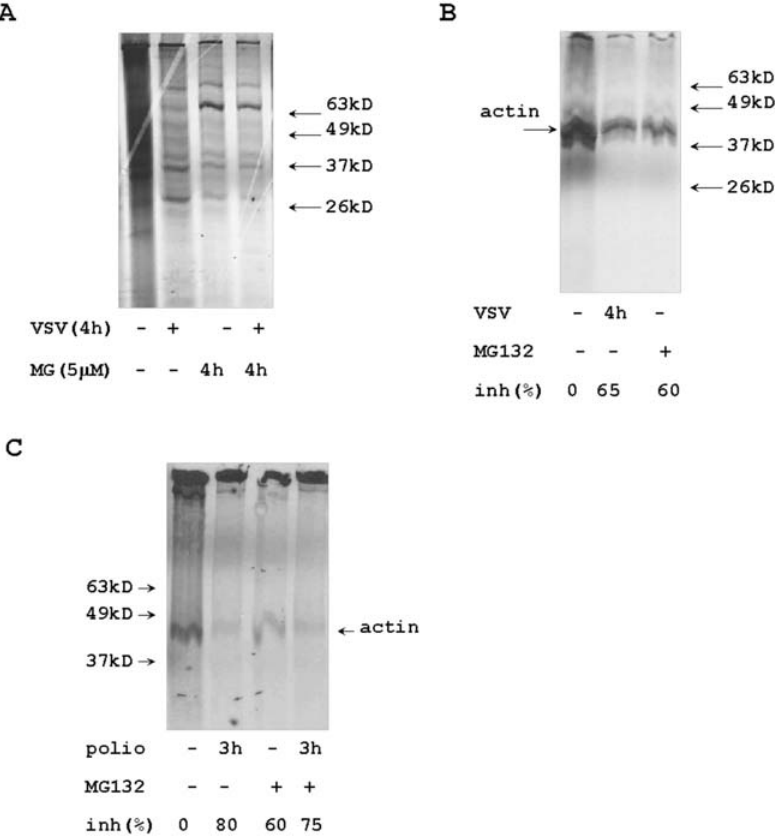
Figure 8. The effect of MG132 and virus infection on cellular protein synthesis. (A) Protein extracts were purified from control HeLa cells, cells infected with VSV for 4 h, cells treated with 5 m M of MG132 for 4 h, and cells infected with VSV and treated with MG132 for 4 h. All cells were incubated with S 35 methionine/cysteine for last 30 min before the protein extracts purification. Cytoplasmic protein extracts were analyzed by electrophoresis and autoradiography. (B) Cytoplasmic protein extracts from control, VSV infected, and MG treated cells were precipitated with anti- actin Abs, and the complexes were purified on protein A agarose. S 35 labeled actin was analyzed by electrophoresis and autoradiography. (C) Cytoplasmic S 35 -labeled protein extracts from MG-treated and poliovirus-infected cells were precipitated with anti-actin Abs and analyzed as described in panel B. All protein bands’ intensity was detected by ImageJ software to calculate percentage of protein synthesis inhibition.